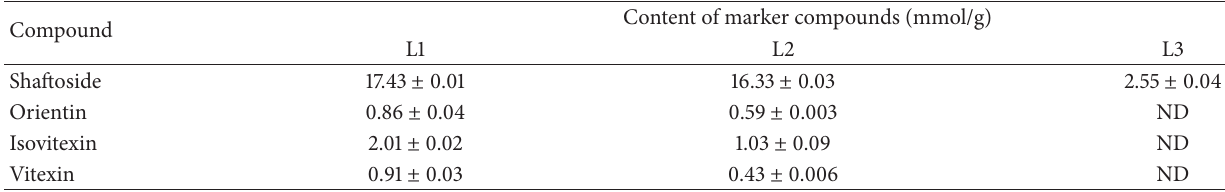
AUC: area under curve. Table 3: Content of shaftoside, orientin, isovitexin, and vitexin in samples of C. nutans from different locations. L1: Taiping, Perak, L2: Kota Tinggi, Johor, and L3: Sendayan, Negeri Sembilan.